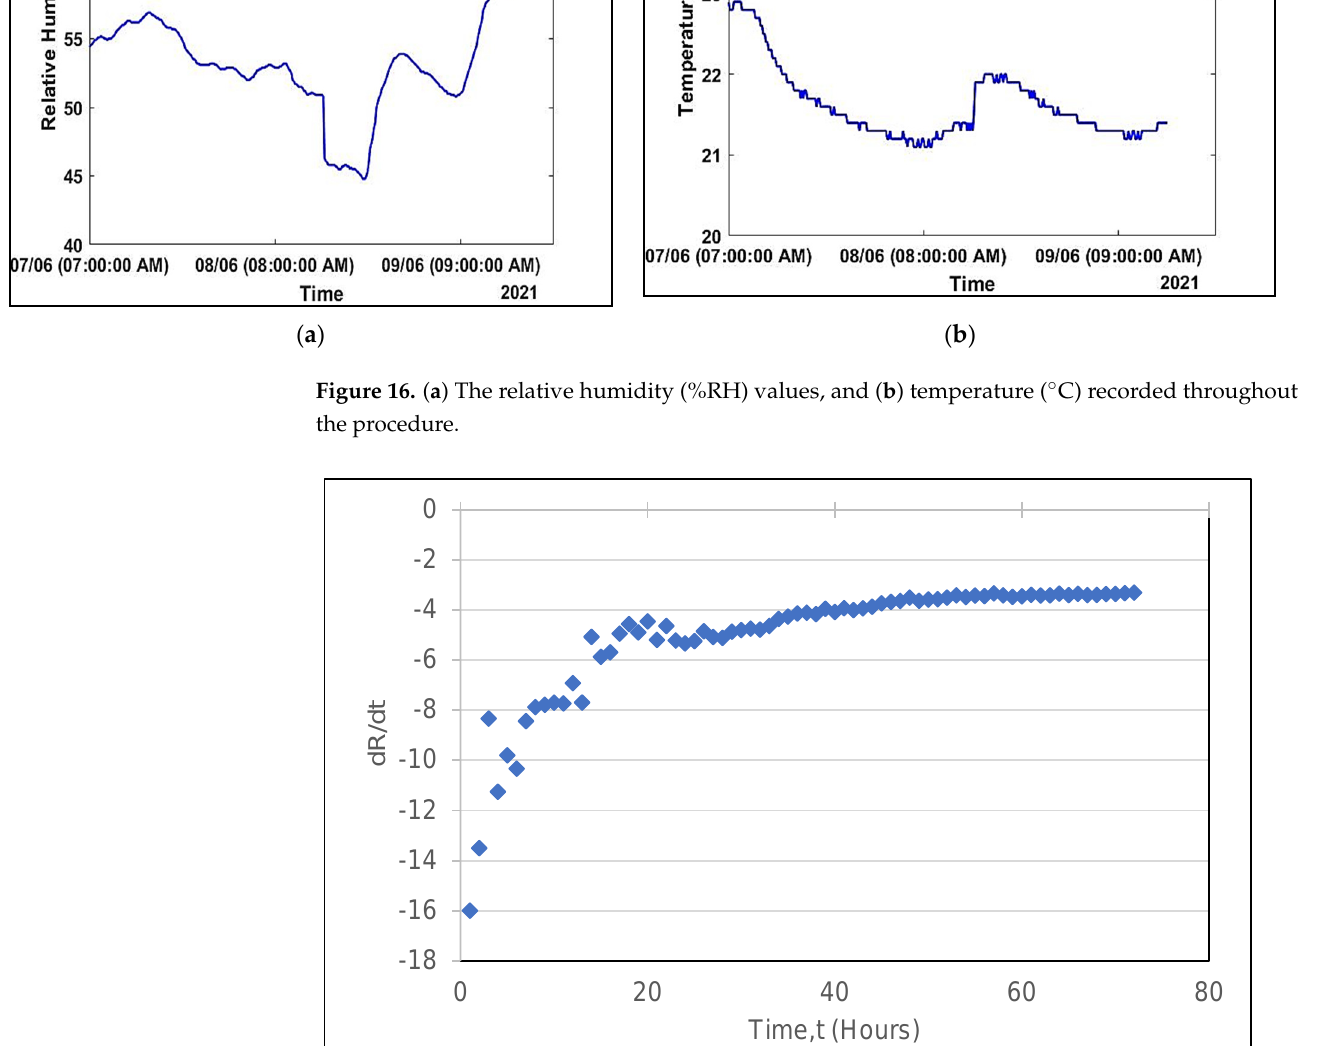
Figure 17. The graph showing the rate of change of corrosion per hour throughout the test.